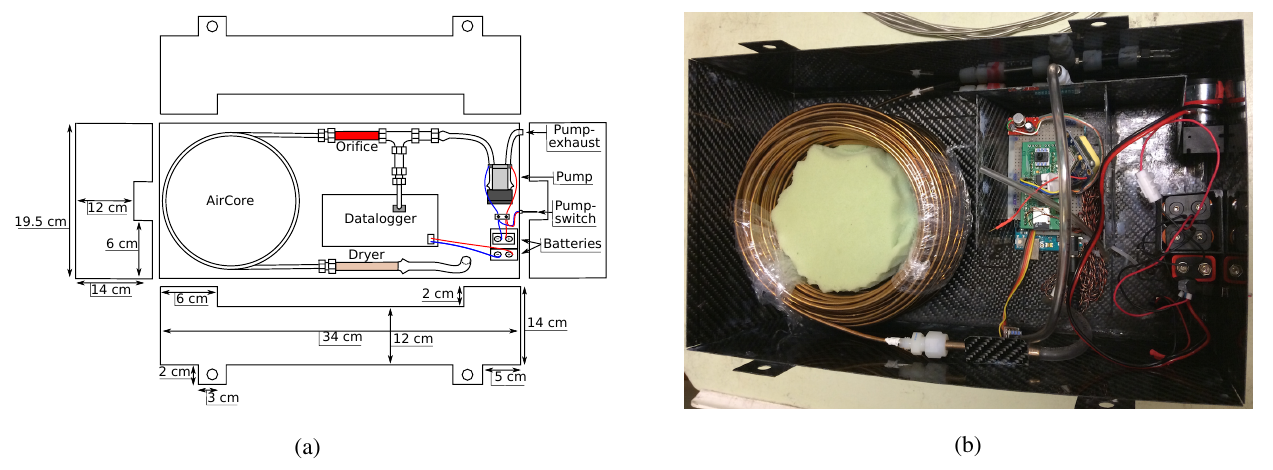
Figure 1. (a) Schematic design of the UAV AirCore system. (b) Image of the UAV AirCore system.